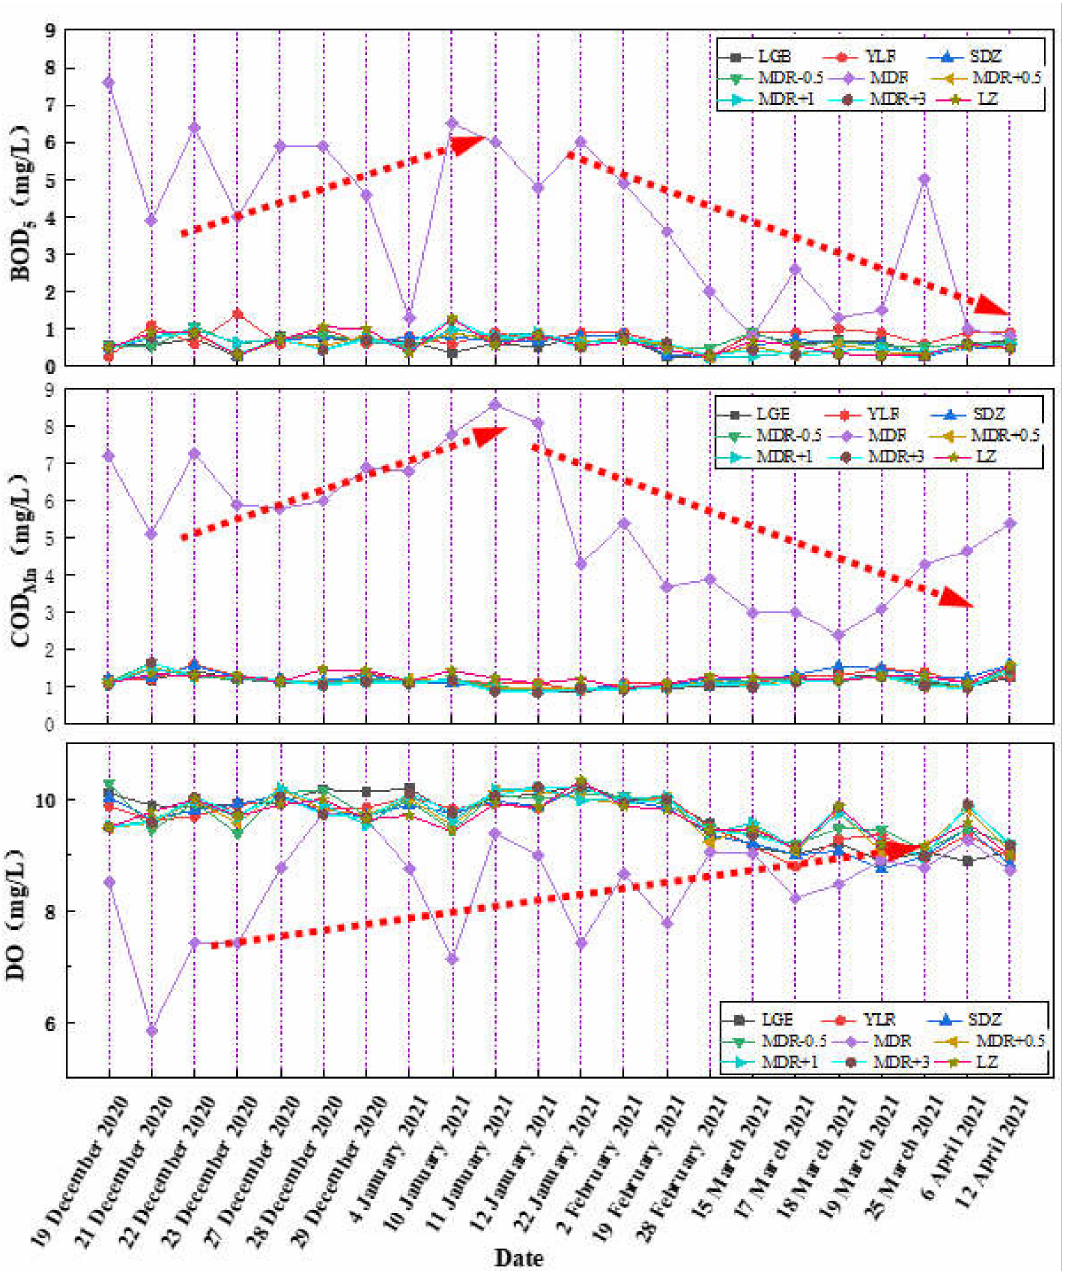
Figure 9. Changes in oxidation parameters at each monitoring point during the impoundment test stage (2020–2021). Luoguo Bridge, LGB; Yalong River, YLR; Sanduizi, SDZ; 0.5 km upriver of Madian River, MDR − 0.5; Madian River, MDR; 0.5 km downstream of Madian River, MDR + 0.5; 1 km downstream of Madian River, MDR + 1; 3 km downstream of Madian River, MDR + 3; Lazha,